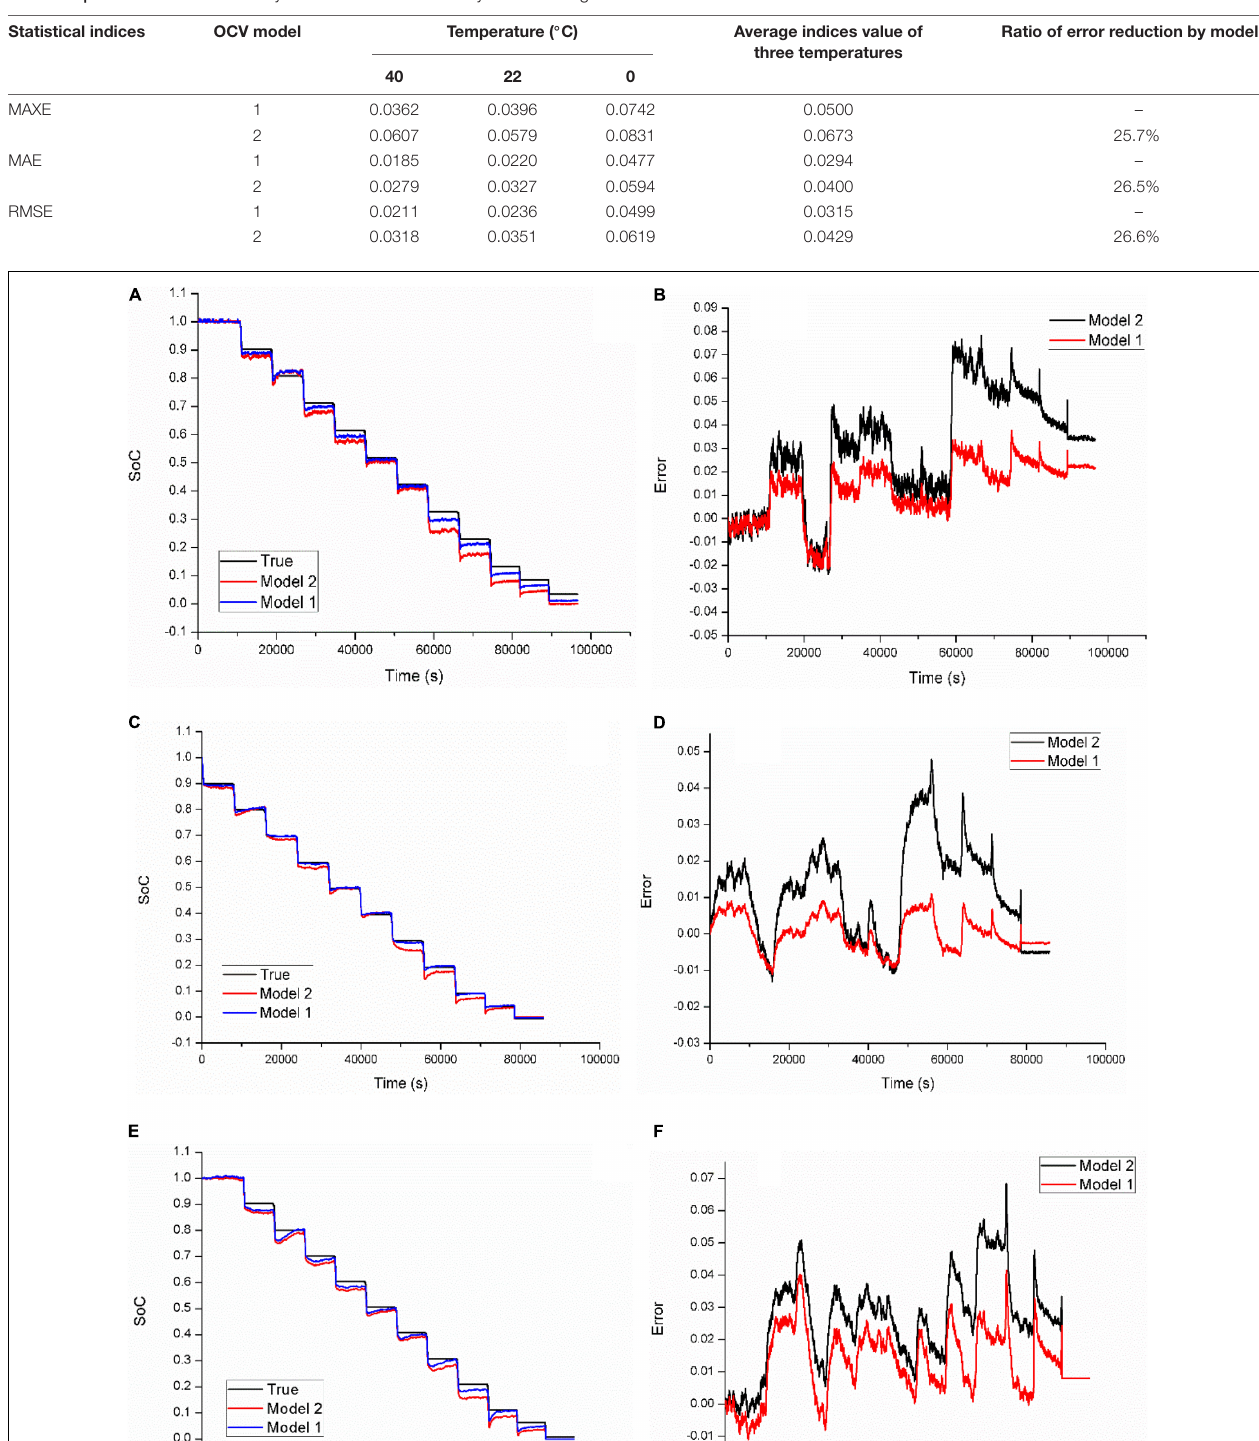
TABLE 2 | Estimate errors and analysis results for the UDDS dynamic loading condition.